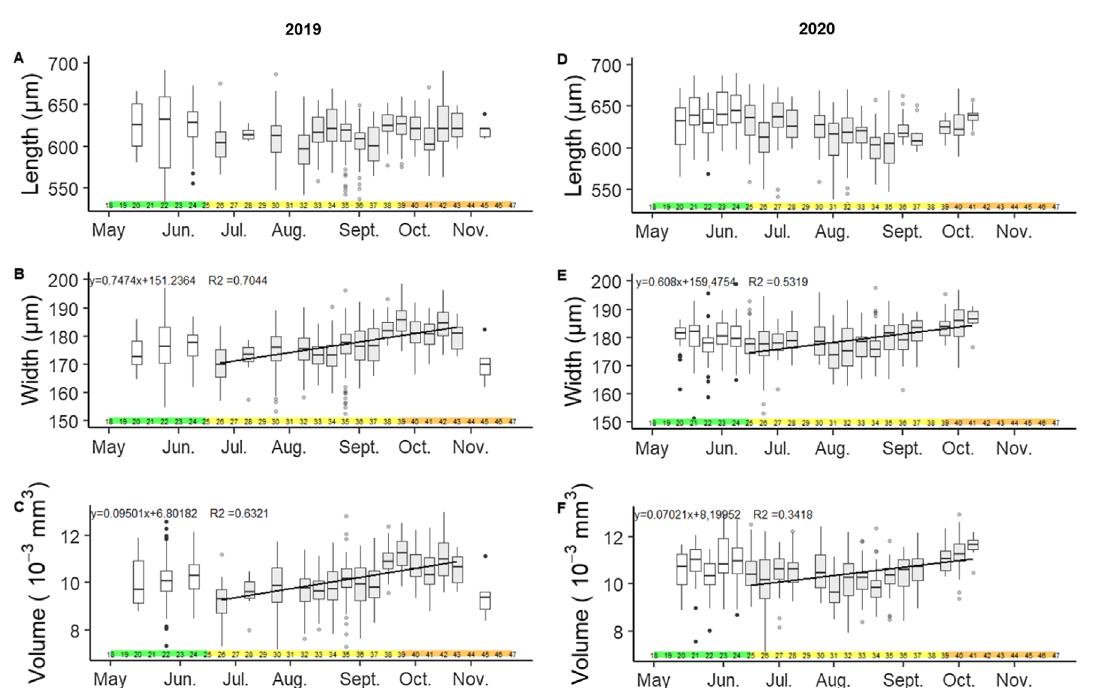
Figure 5. Evolution of morphological parameters of Ae. japonicus eggs throughout the year. Figure 5A: length; Figure 5B: width; Figure 5C: volume, data of 2019. Figure 5D: length; Figure 5E: width; Figure 5F: volume, data of 2020. Data come from the Reichstett fi eld area. Eggs are batched according to the calendar week of collection. Corresponding months and seasons in coloured horizontal bars are also shown (green = spring, yellow = summer, orange = autumn). Boxplots of corresponding weeks considered for the linear regression are shown in grey. In Figures 5B and 5C for 2019, linear regressions in solid black lines ignore data point of weeks 20, 22, 24 and 45 as well, which are shown in a white boxplot. For 2020, data for weeks 20 – 25 are discarded.